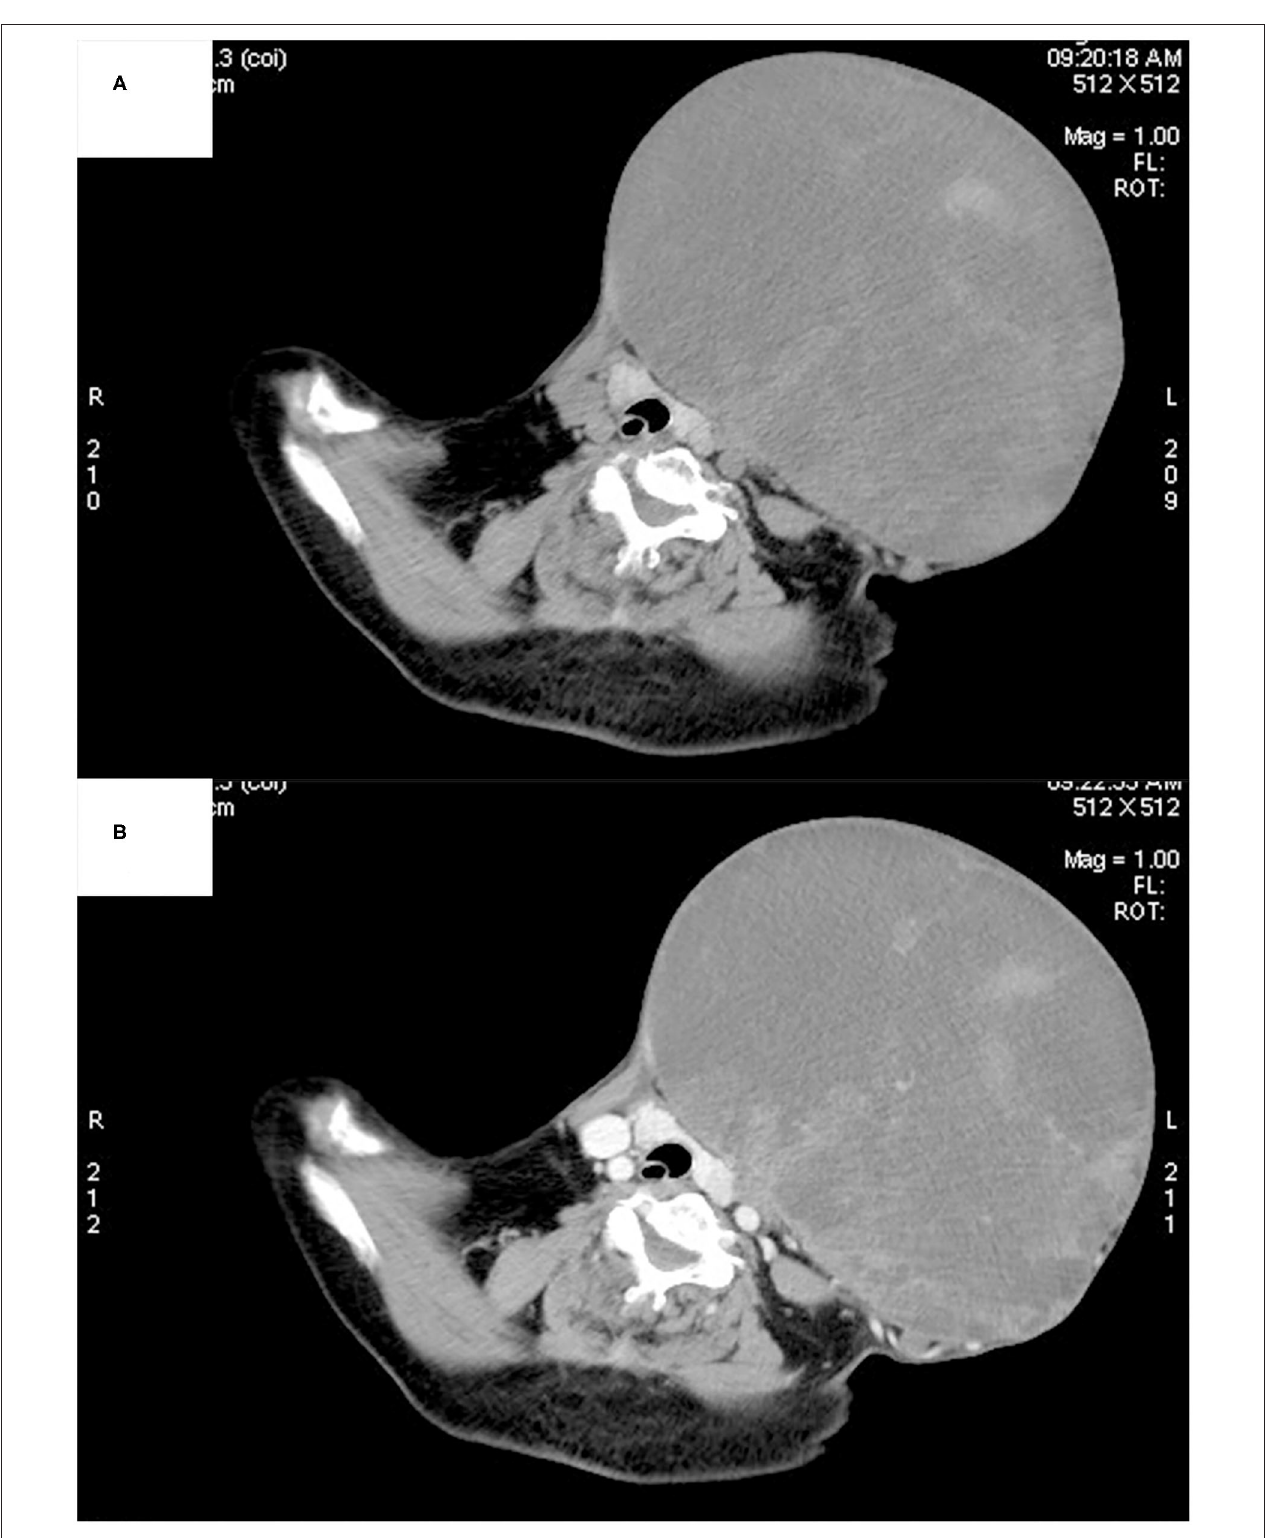
FIGURE 2 | Computed tomography showed a large mixed-density lesion in the left anterior neck, with the trachea and thyroid gland being squeezed to the right side. The internal density of the mass was uneven, with patchy high-density shadows (A) . No obvious enhancement was found in the arterial phase (B) .